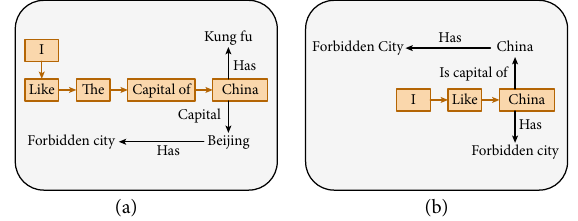
Fig. 1 Two subgraphs from commonsense knowledge graph illustrate the necessity of commonsense knowledge for sentence similarity. The words which are in the pink box make a sentence, and the rest of the words are the nodes connected to the words of the sentence in the commonsense knowledge